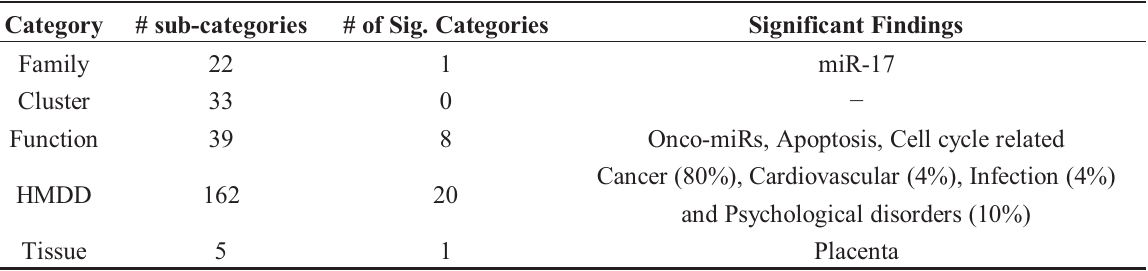
Table 6. Summary of significant findings from miR annotation analysis in TAM (A Tool for Annotations of miRs)